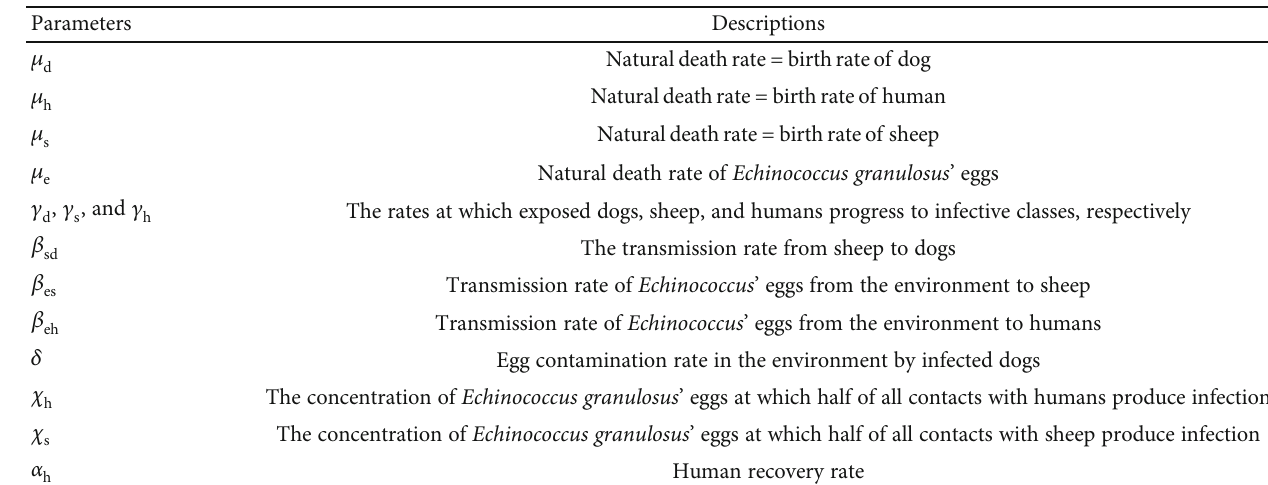
Table 2: Descriptions of